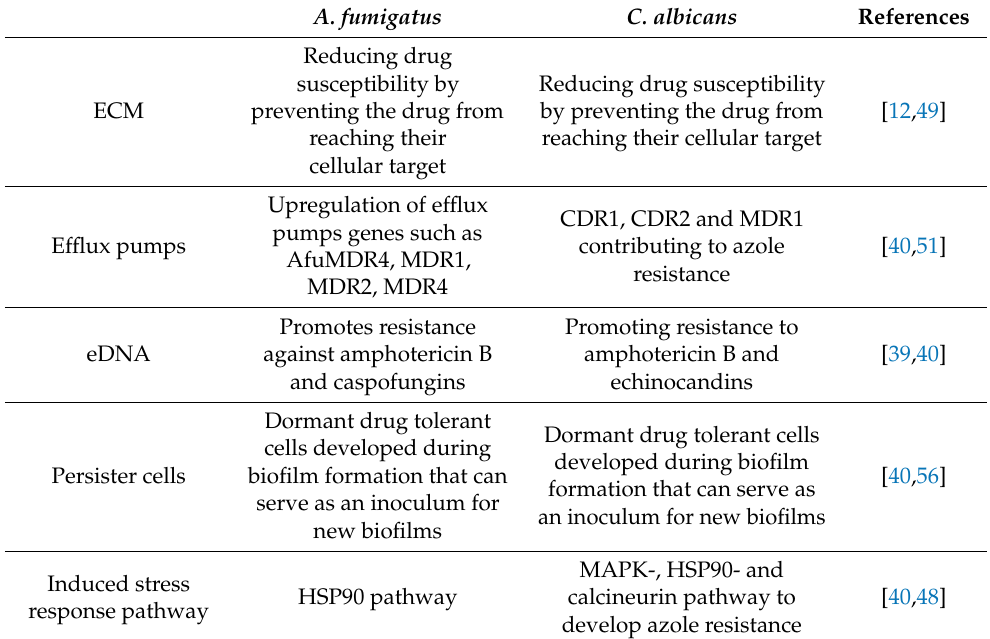
Table 1. Drug resistance mechanisms in A. fumigatus and C. albicans biofilm.